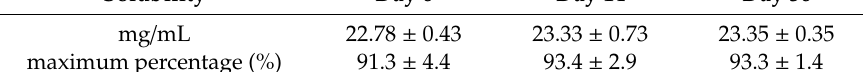
Table 2. Thestabilityofselectedmicroemulsion, formulationBloadedwithmagnolol. (Mean ± SD, n = 3).